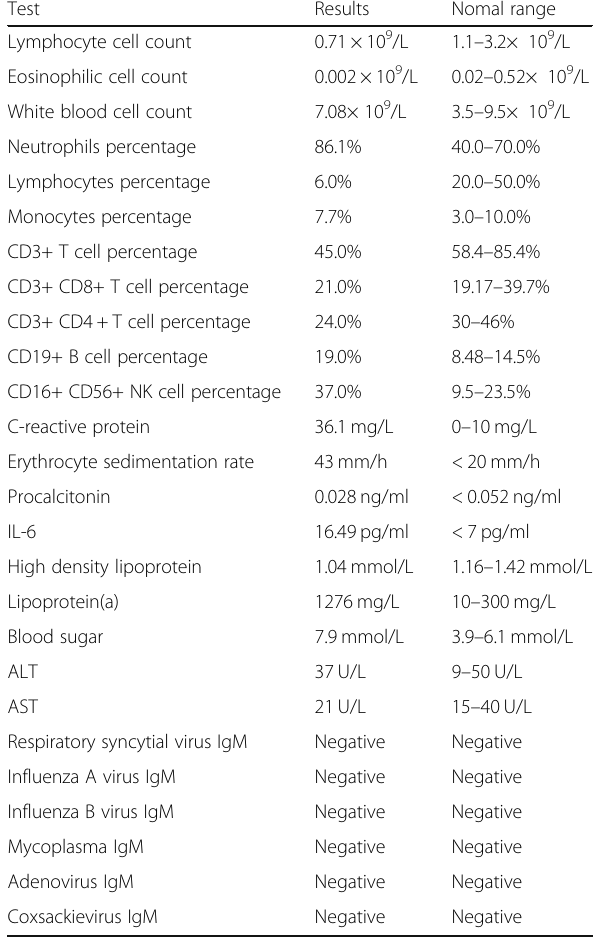
Table 1 The representative laboratory test results